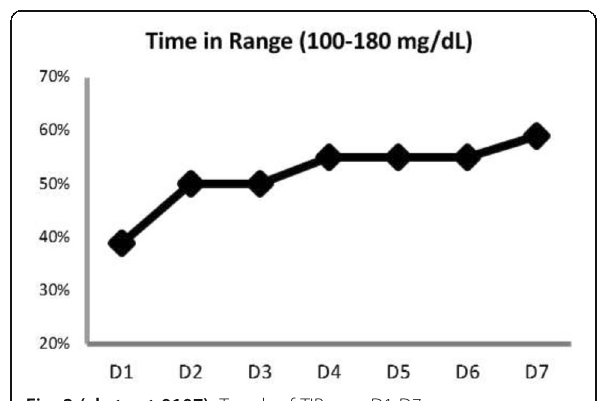
Fig. 2 (abstract 0107). Trends of TIR over